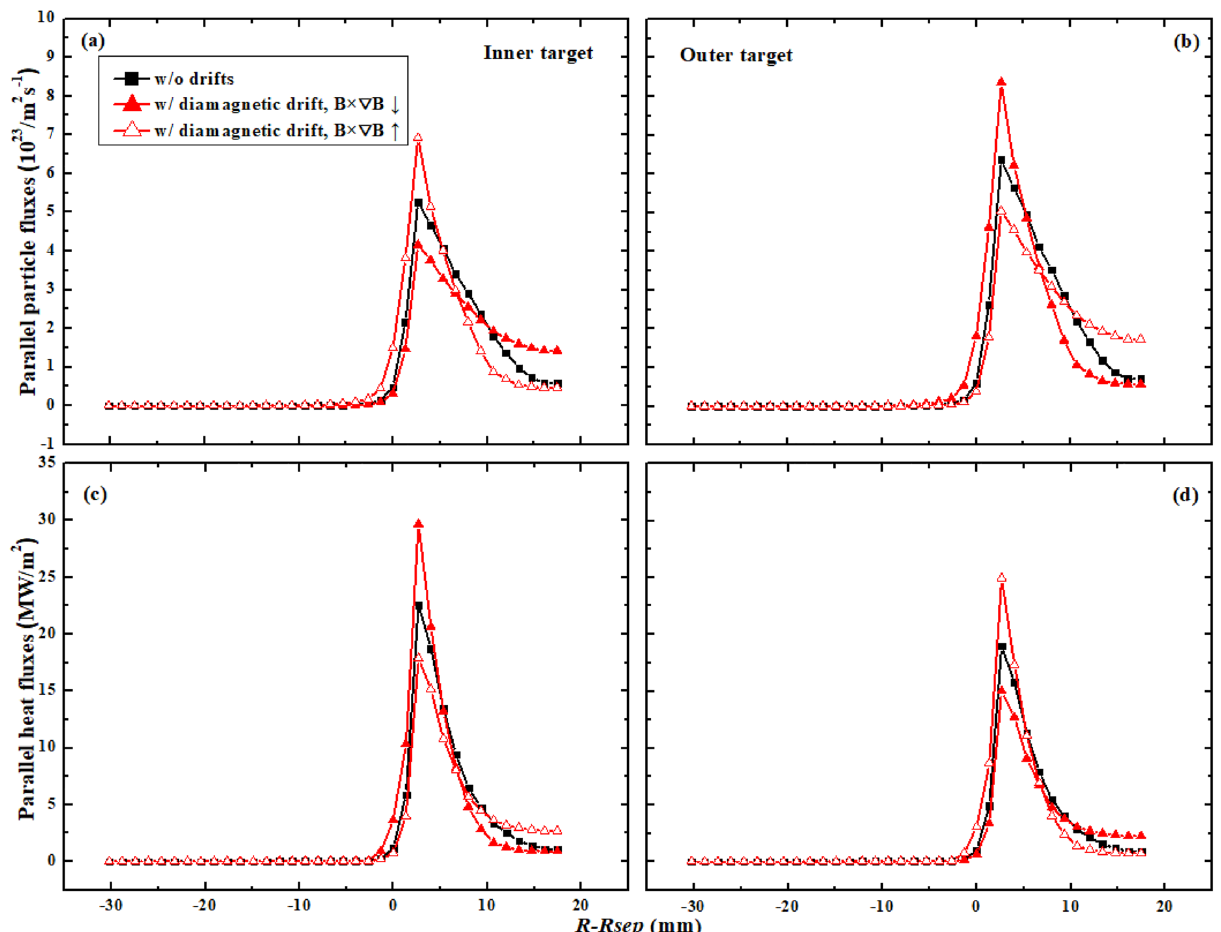
Figure 3. The divertor particle and heat fluxes at the inner and outer targets for the case without drifts and the cases with only diamagnetic